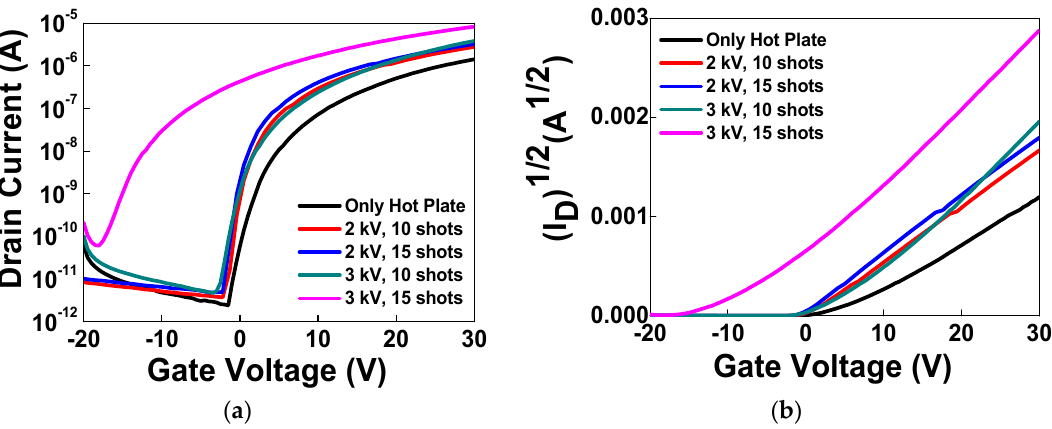
Figure 2. ( a ) The drain current (logarithmic scale) versus gate voltage (V G ) plots and ( b ) the square root of drain current versus gate bias ( √ I D –V G ) transfer curves of IGZO thin film transistors (TFTs) on Si wafer annealed on only hot plate and with additional IPL processes with 2~3 kV and 10~15 shots, as obtained under a drain bias (V D ) of 30 V. (Pulse widths: 1 ms for 2 kV, 2 ms for 3 kV).